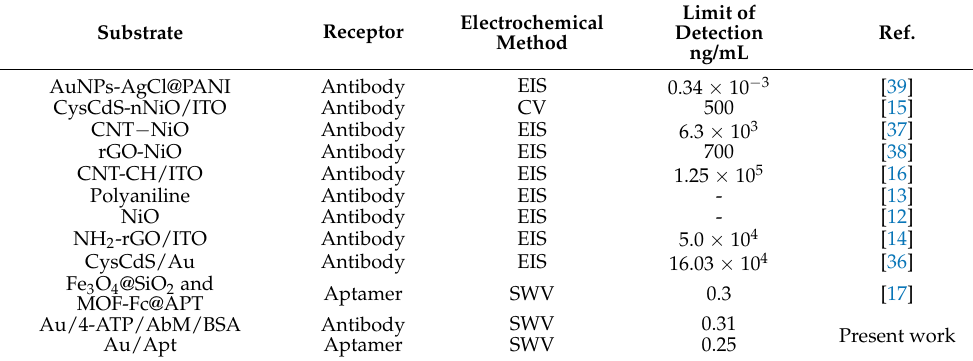
Table 2. Comparison of various biosensors for the detection of LDL described in the literature with the immunosensor (Au/4-ATP/AbM-anti-apoB/BSA) and aptasensor (Au/Apt-LDL, 6MHol) developed in this